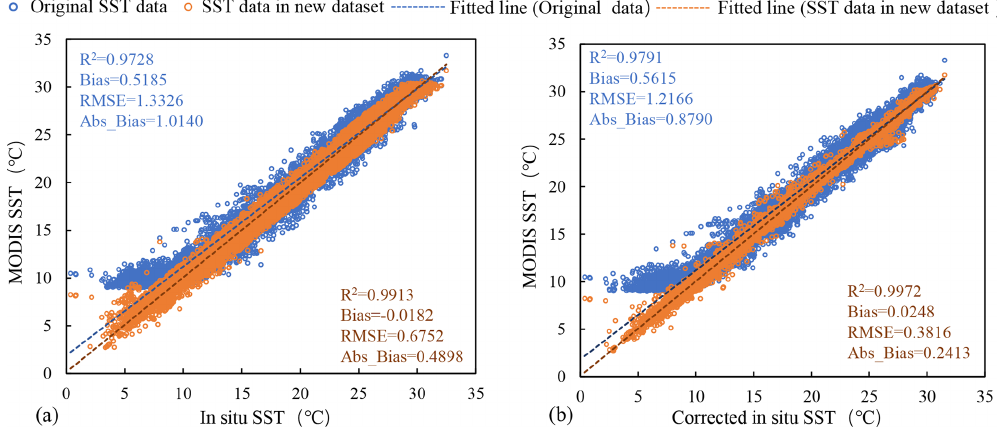
Figure 15. The scatter diagrams of the low-quality MODIS SST data and the reconstruction results versus their corresponding in situ SST data from 2002 to 2019. The blue points indicate low-quality MODIS SST pixel values. The orange points represent the values in reconstructed SST data, and the statistical accuracy measures ( R 2 , bias, Abs_Bias, and RMSE) are also indicated.